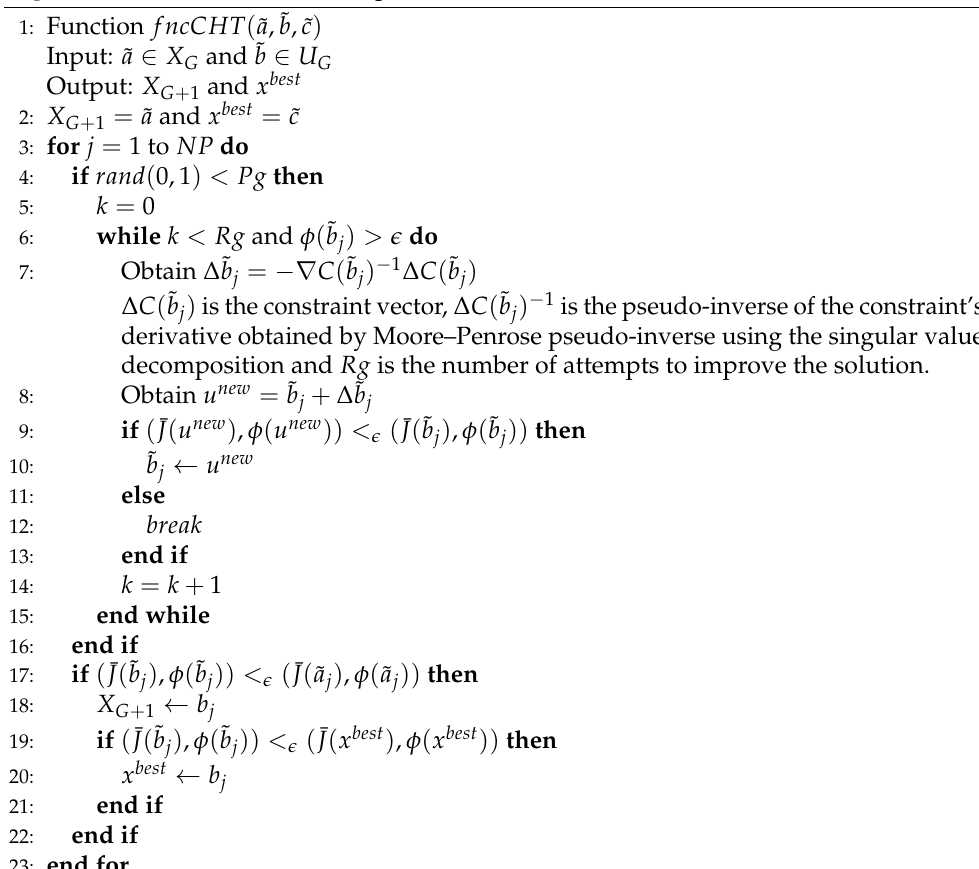
Algorithm 6 (cid:101) -constraint method